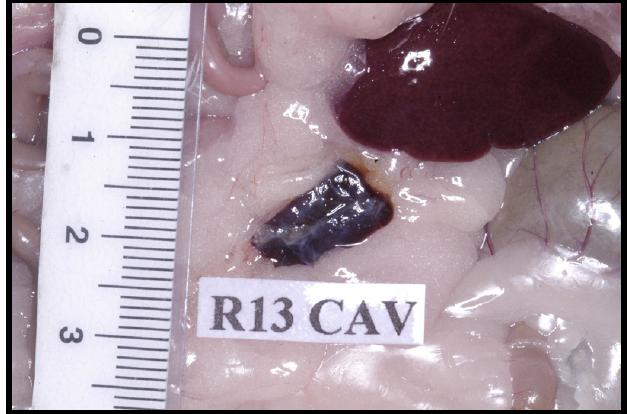
FIGURE 2 - The group I graft, emphasizing its implantation in the adjacent tissues